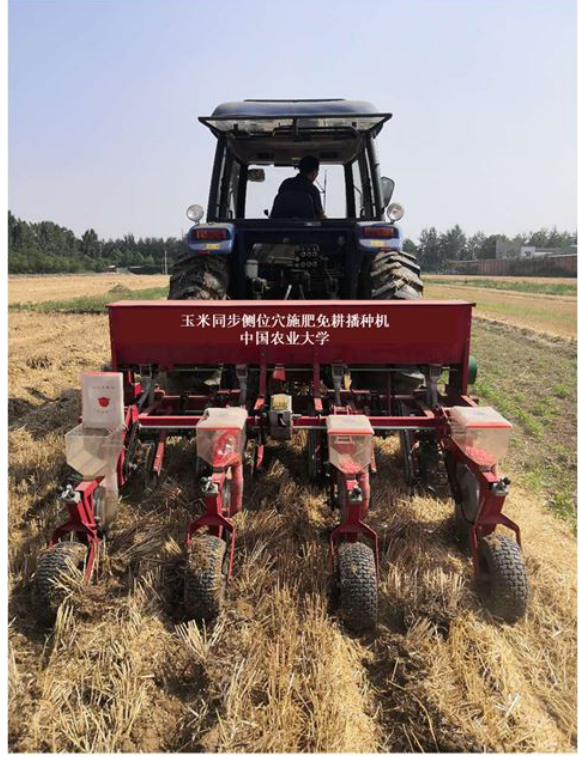
Fig. 9. Back view of maize precision seeder